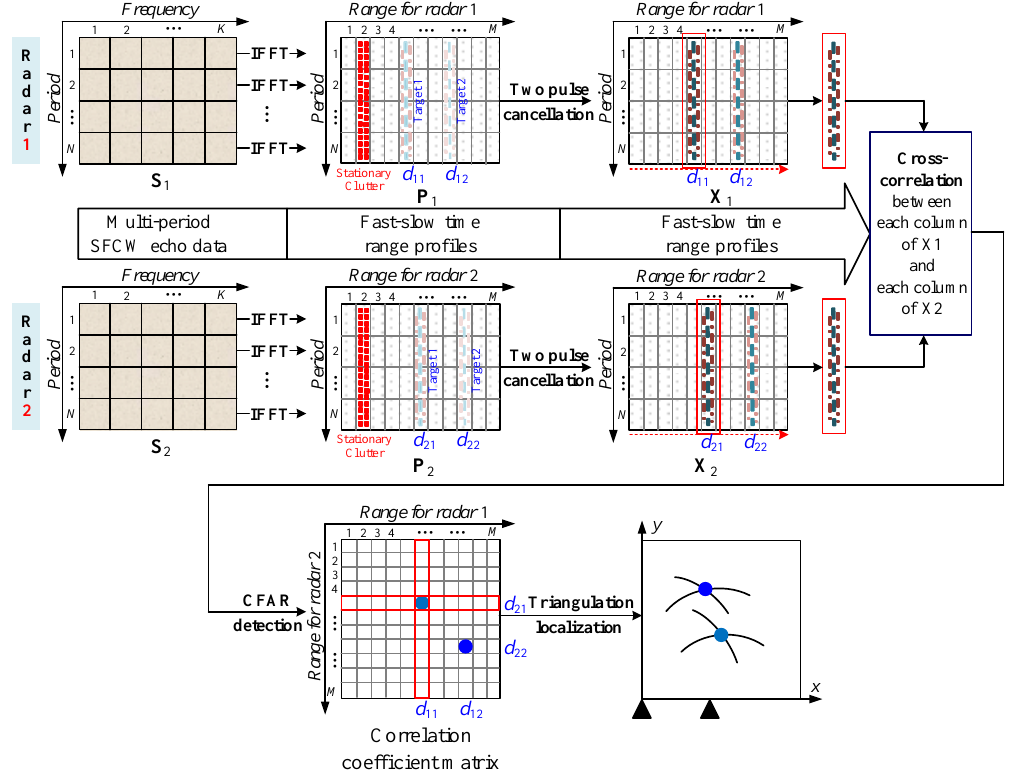
Figure 2. Detection and localization flowchart based on dual-station